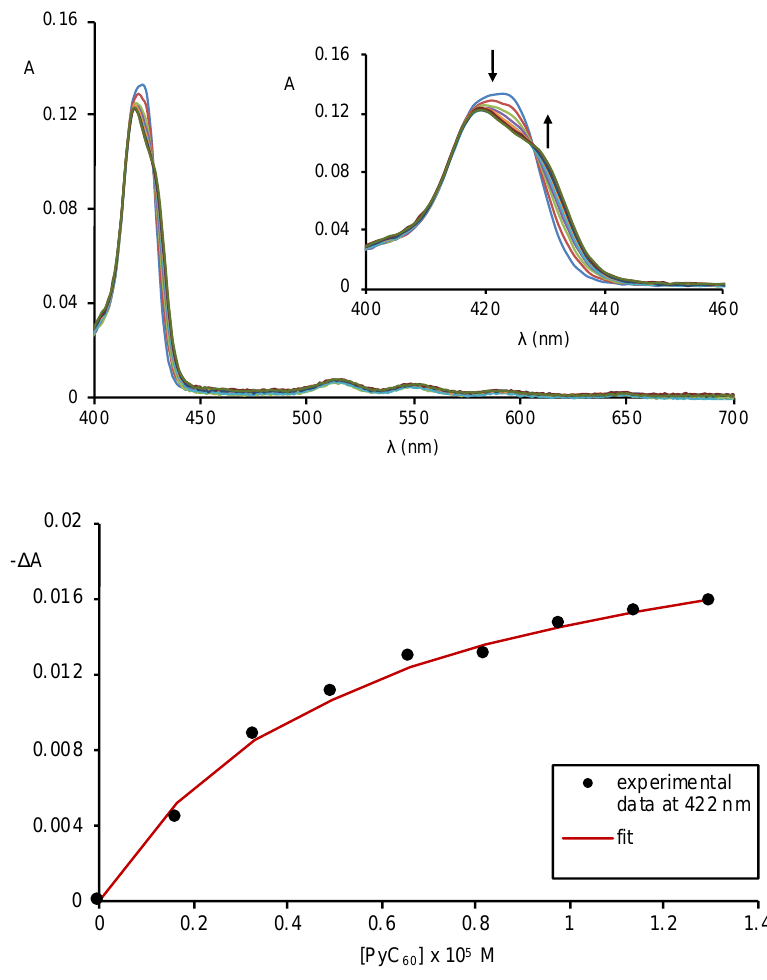
Figure 4. Absorption spectra of 6 (1.0 × 10 −7 M) upon addition of PyC 60 (0 – 113 equiv.) in toluene at 23 °C ( upper part ) and experimental data at 422 nm fitted to a non-linear 1:1 binding model ( lower part ).